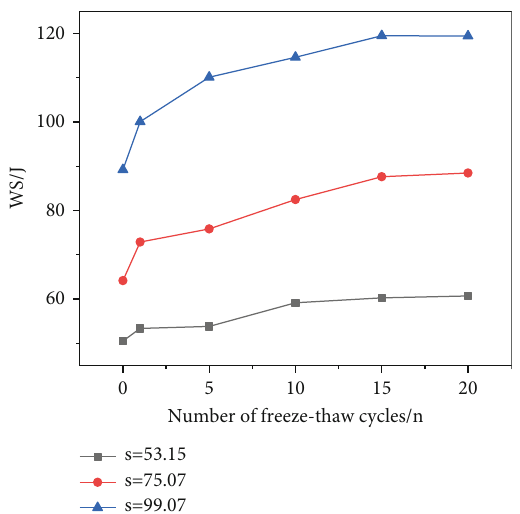
Figure 9: The variation curve of dissipative energy with the number of freeze-thaw cycles under di ff erent strain